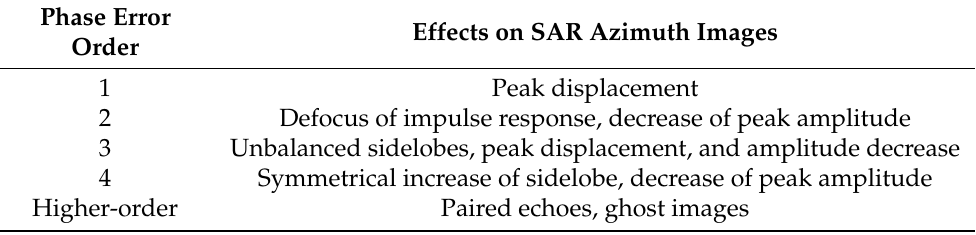
Table 5. Effects of different order phase errors on azimuth